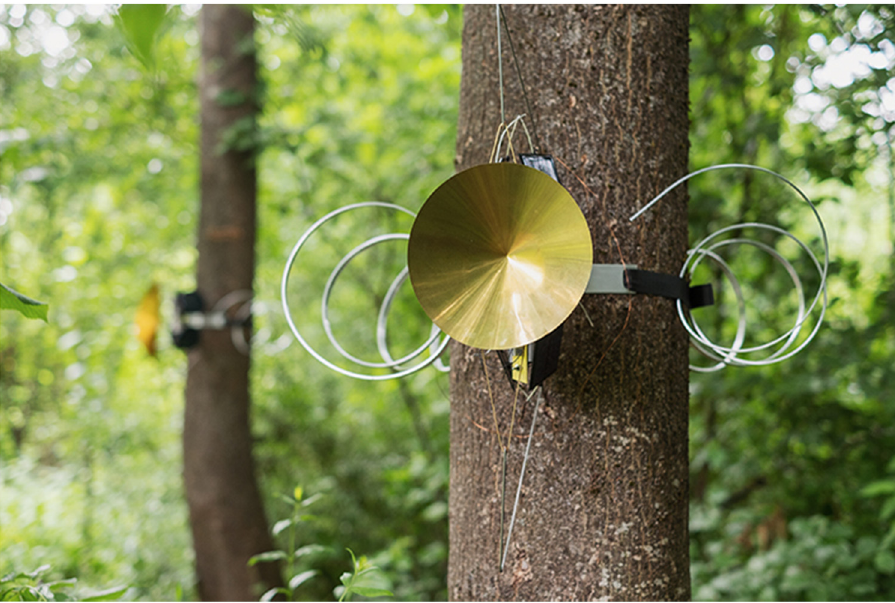
Figure 2: Arboreal Receptors ( 2021 ) installation view, Ioana Vreme Moser. © Maximilian Pramatarov. Courtesy of IMA Institute of Media